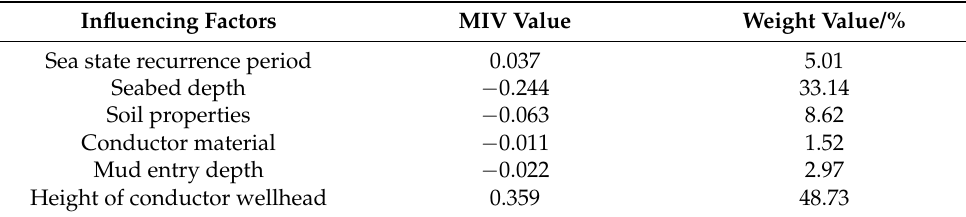
Table 6. MIV value and weight value of each influencing factor of conductor